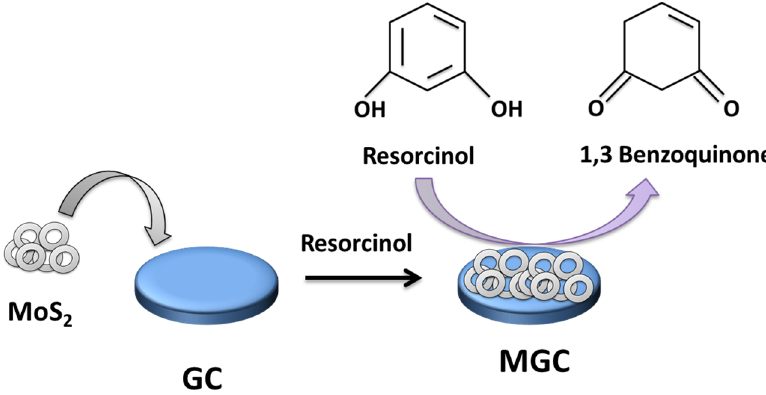
Scheme 1. Schematic representation of the fabrication of the MGC.